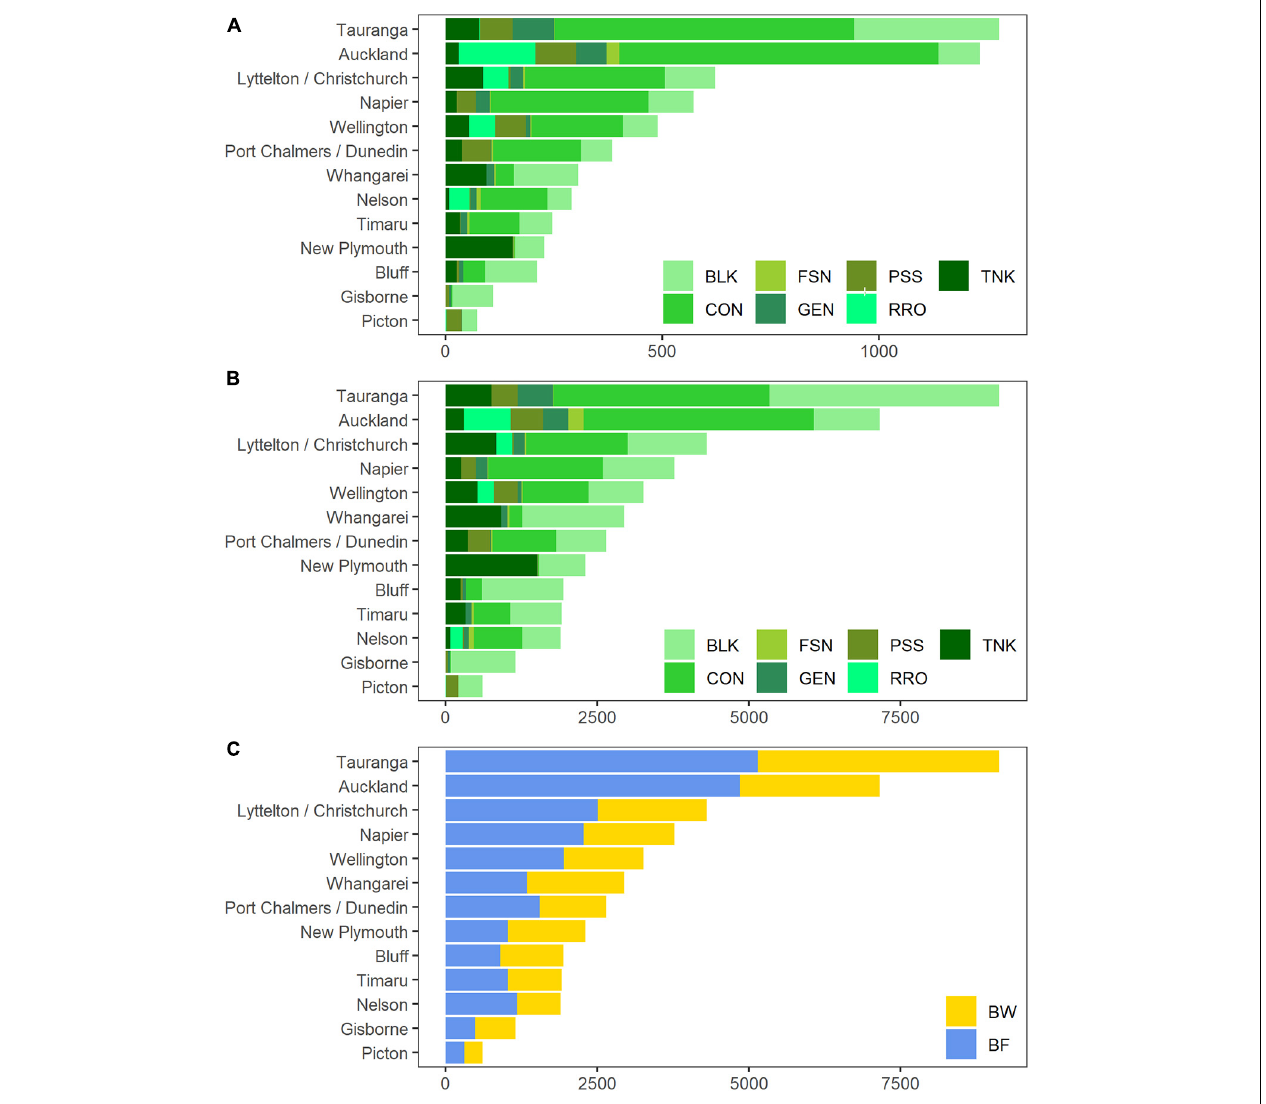
FIGURE 4 | (A) Number of vessel visits per vessel type to each port of New Zealand in 2015 and 2016. (B) Relative biosecurity risk of each port, showing proportion of total risk per vessel type. (C) Relative biosecurity risk of each port, showing proportion of total risk due to ballast water (BW) or biofouling